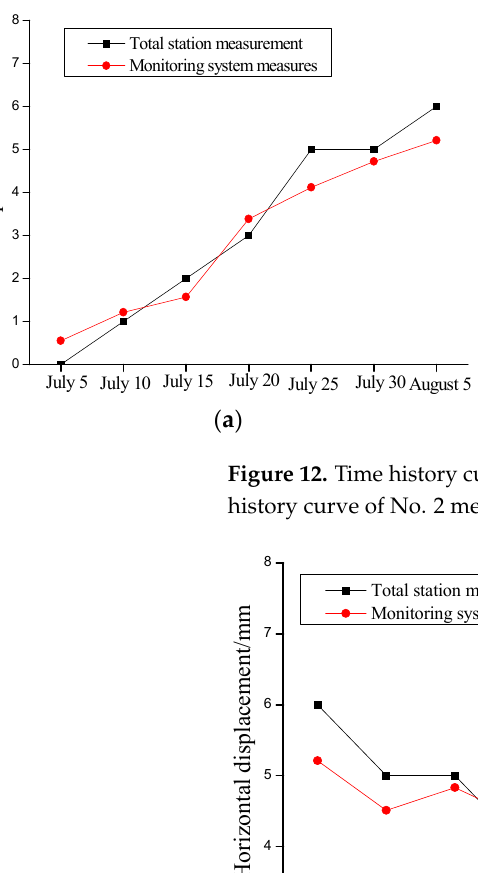
Figure 12. Time history curve comparison. ( a ) Time history curve of No. 1 measuring point, ( b ) Time